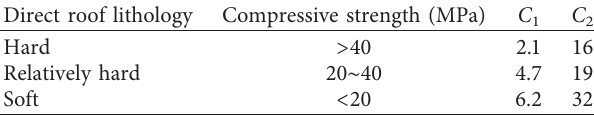
Table 1: Coefficients for height of caving